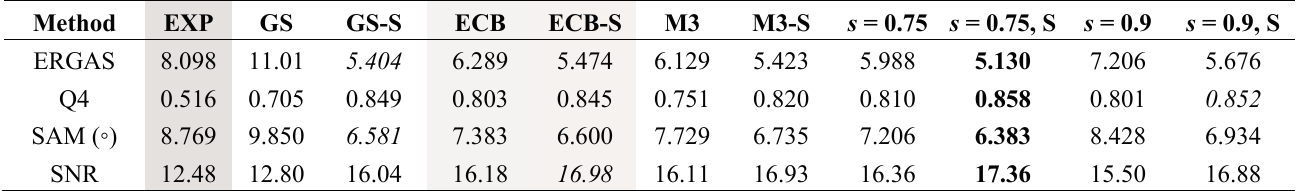
Table 10. Quantitative comparison of the fusion results to check the synthesis property of the Wald’s protocol for the WorldView-2 group 2 dataset at the reduced scale, i.e ., at 2.0 m. The font face indicators are identical to those in Table 2.